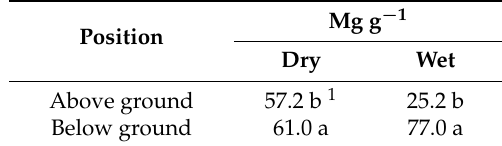
Table 2. Average tissue level values of N content for the interaction of bag position and season for two cover crops species in an Oxisol in the Agricultural Experiment Substation of Isabela, Puerto Rico.